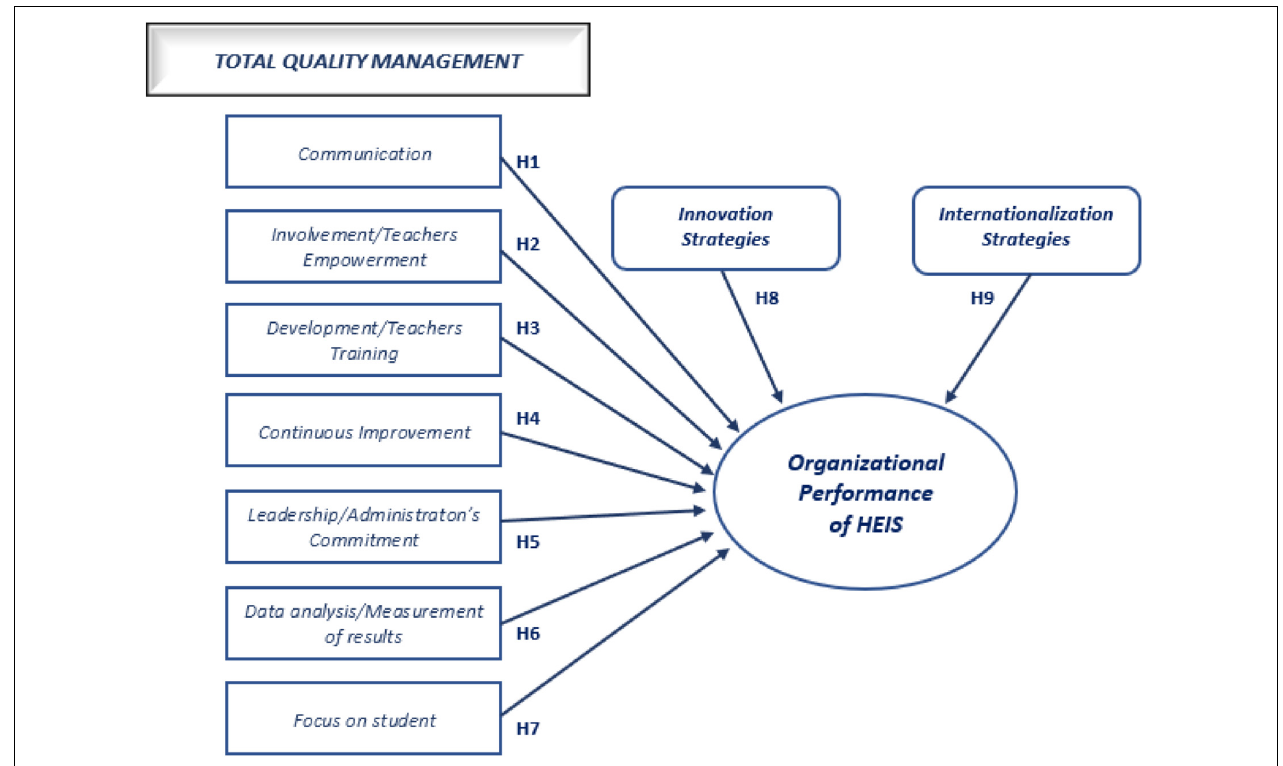
FIGURE 1 | Conceptual model and research